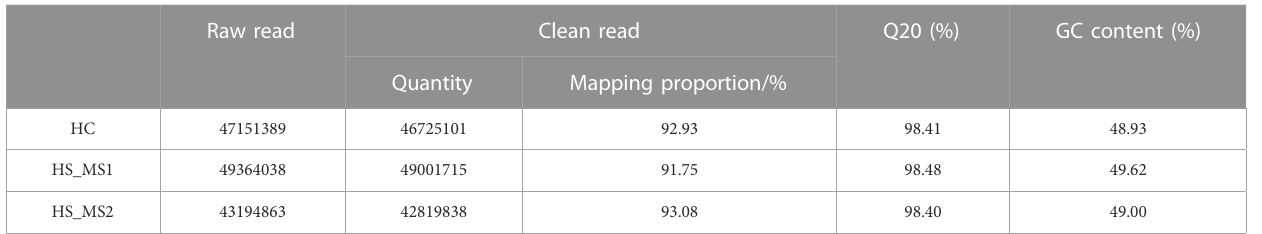
TABLE 7 Sequencing data of mRNA libraries (n =